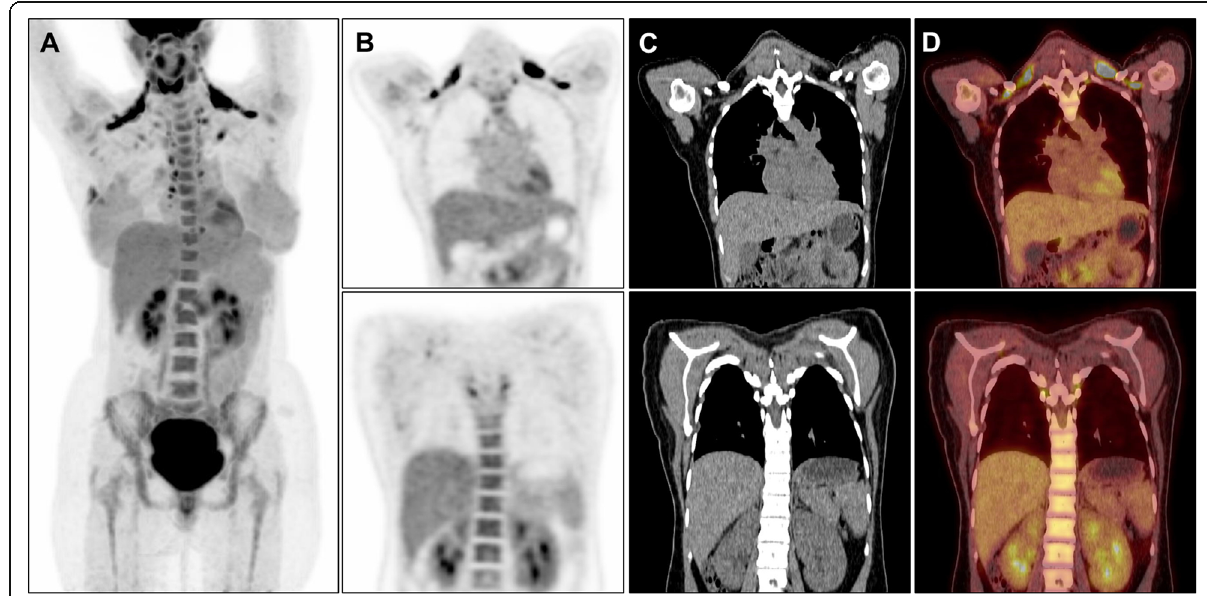
Fig. 4 Brown fat uptake: 18 F-FDG PET/CT scan of a 28-year-old female with basal-like right breast cancer: a maximum intensity projection and b coronal PET show intense 18 F-FDG uptake in the cervical, supraclavicular, and paravertebral regions. c The corresponding CT and d coronal PET/ CT fusion images reveal that 18 F-FDG uptake is corresponding to fatty tissue and there is no abnormal lymph node or muscle uptake, denoting activated